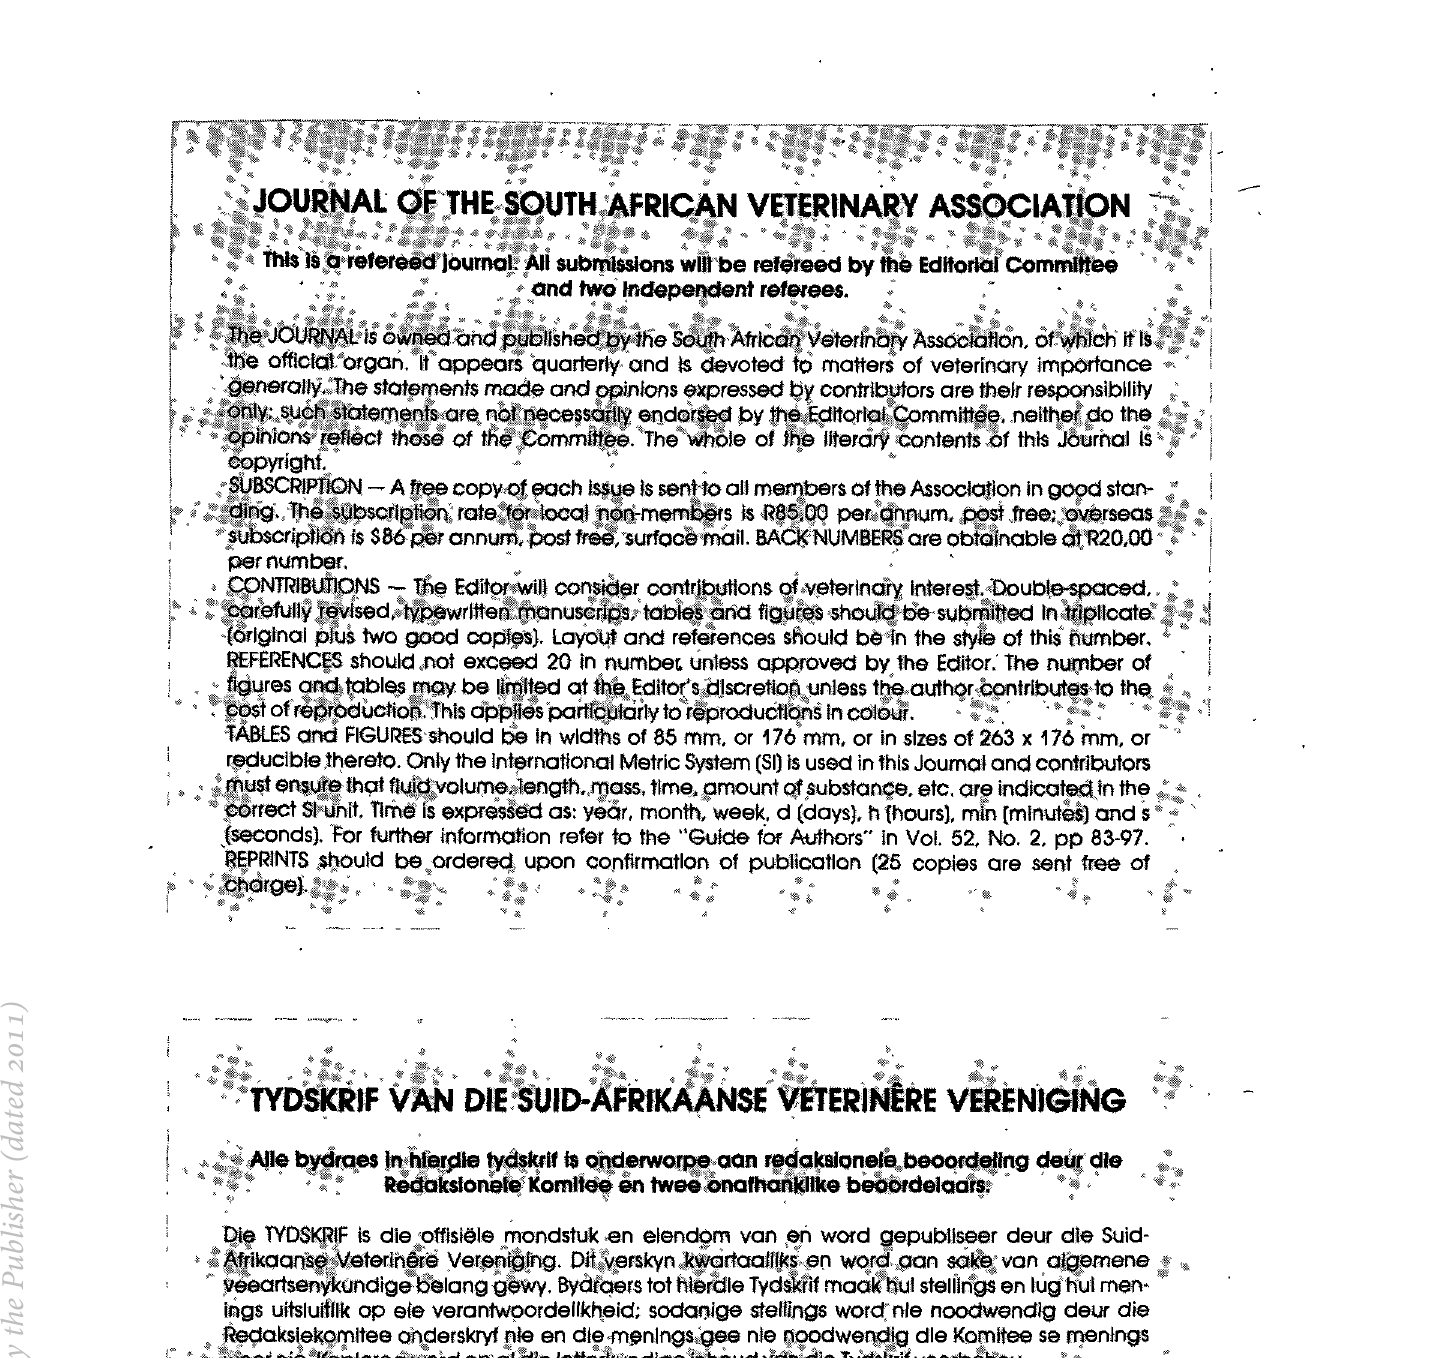
Vereniging gestuur .. Die Intekengeld vir plooslike persone wat nie)ede is nle. beloop